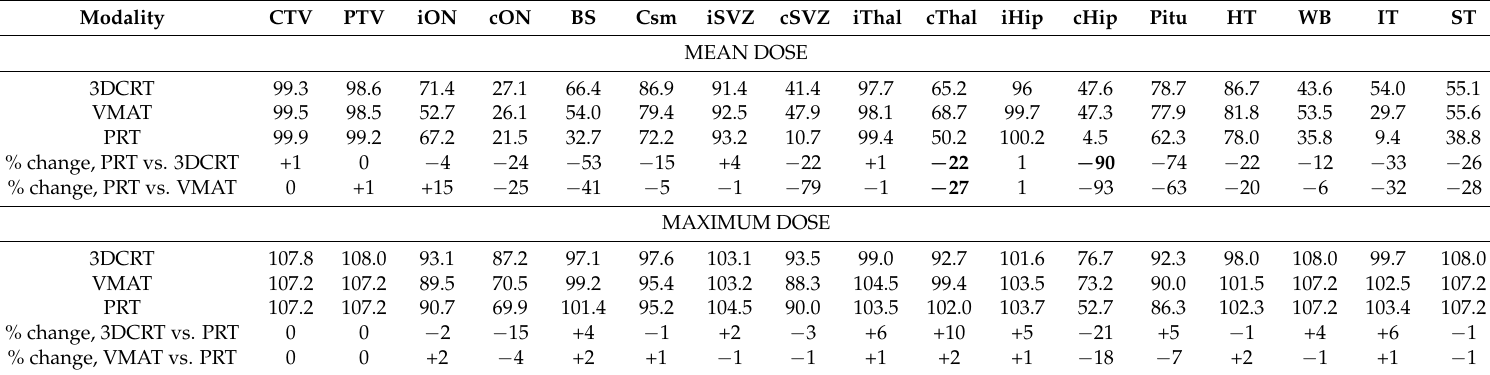
Table 4. Median values for mean and maximum doses to target volumes and organs-at-risk by radiotherapy modality for temporal tumors. Modality